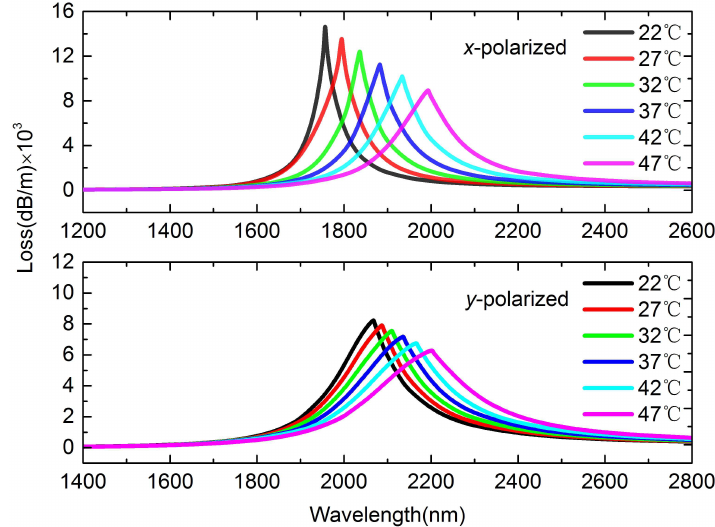
Figure 3. Loss spectra of x - and y-pol when T changes from 22 ◦ C to 47 ◦ C with steps of 5 ◦